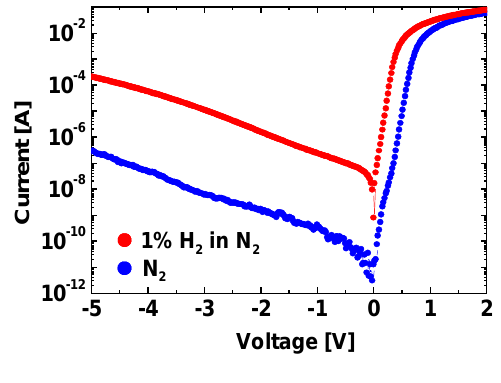
Figure 1. I-V characteristics for a Pt–(Si-doped) GaN Schottky diode in a N the response to the exposure to 1% H permission from reference [17]. Copyright The Japan Society of Applied